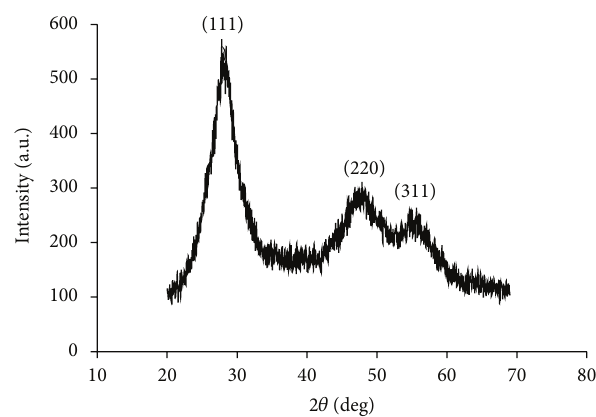
Figure 2: XRD patterns of Mn-doped ZnS QDs aged at 50 ∘ C for